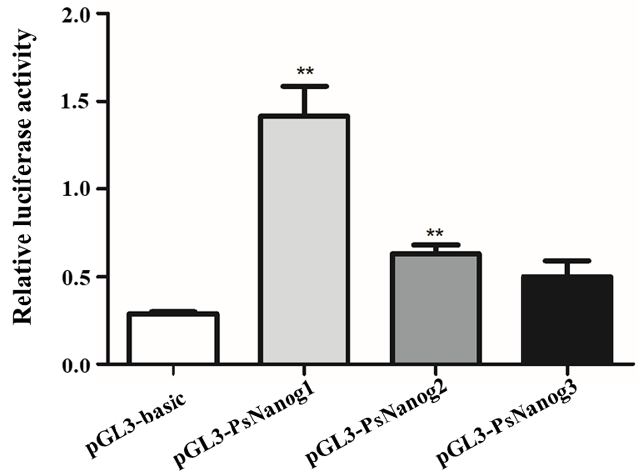
Figure 2. Analysis of PsNanog promoter activities in 293T cells. Firefly luciferase expression levels were normalized to the luciferase activity of internal Renilla control and expressed as relative luciferase units. The results were presented as means ± SD. PsNanog1 ( − 1560 − +1), PsNanog2 ( − 999 − +1), and PsNanog3 ( − 499 − +1) were three promoter fragments. ** represents the significant difference ( p < 0.01).